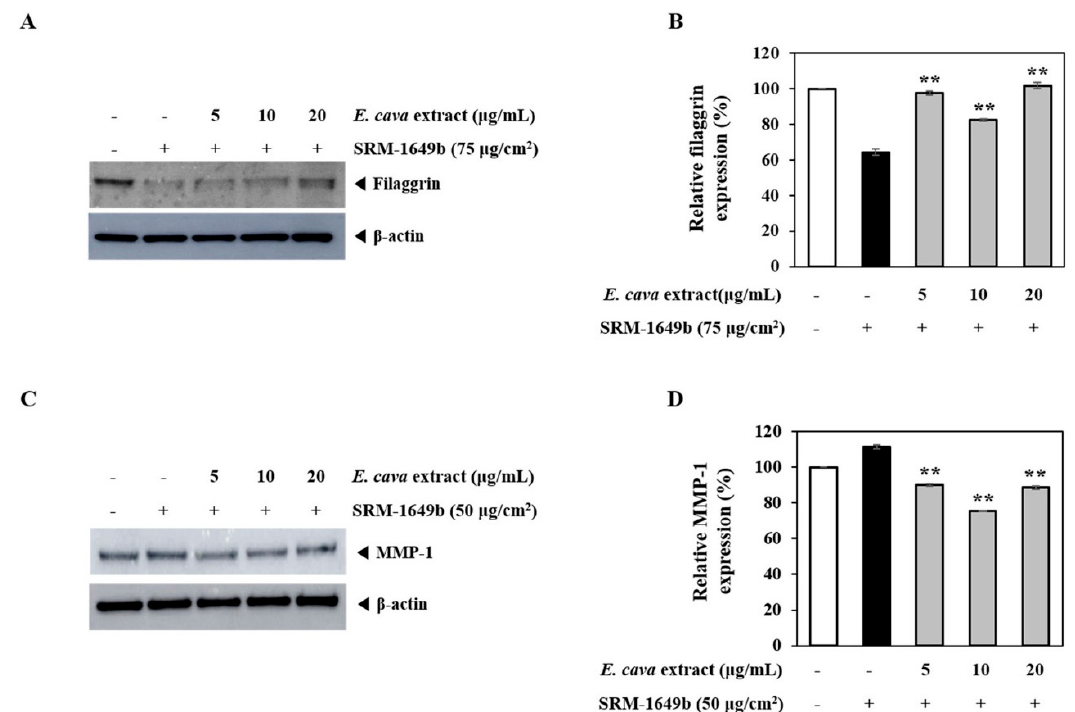
Figure 2. Protein expression of filaggrin and MMP-1 in HFDPC after co-treatment with SRM-1649b and E. cava extract. Western blot showing filaggrin expression levels when treated with SRM-1649b and E. cava extract ( A ). Quantification of filaggrin western blots ( B ). Protein expression by western blot of MMP-1 in co-treatments with SRM-1649b and E. cava ( C ). Quantification of MMP-1 western blots ( D ). Data are representative of three independent experiments and values are expressed as mean ± S.D (* p < 0.05, ** p < 0.01).